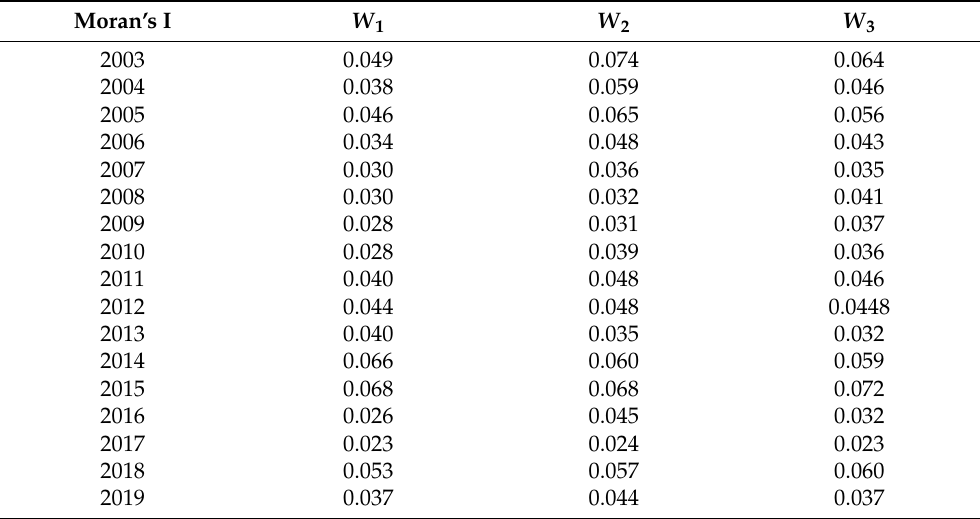
Table 4. Global Moran’s Index of urban land green use efficiency in Chinese cities from 2003 to 2019. Moran’s